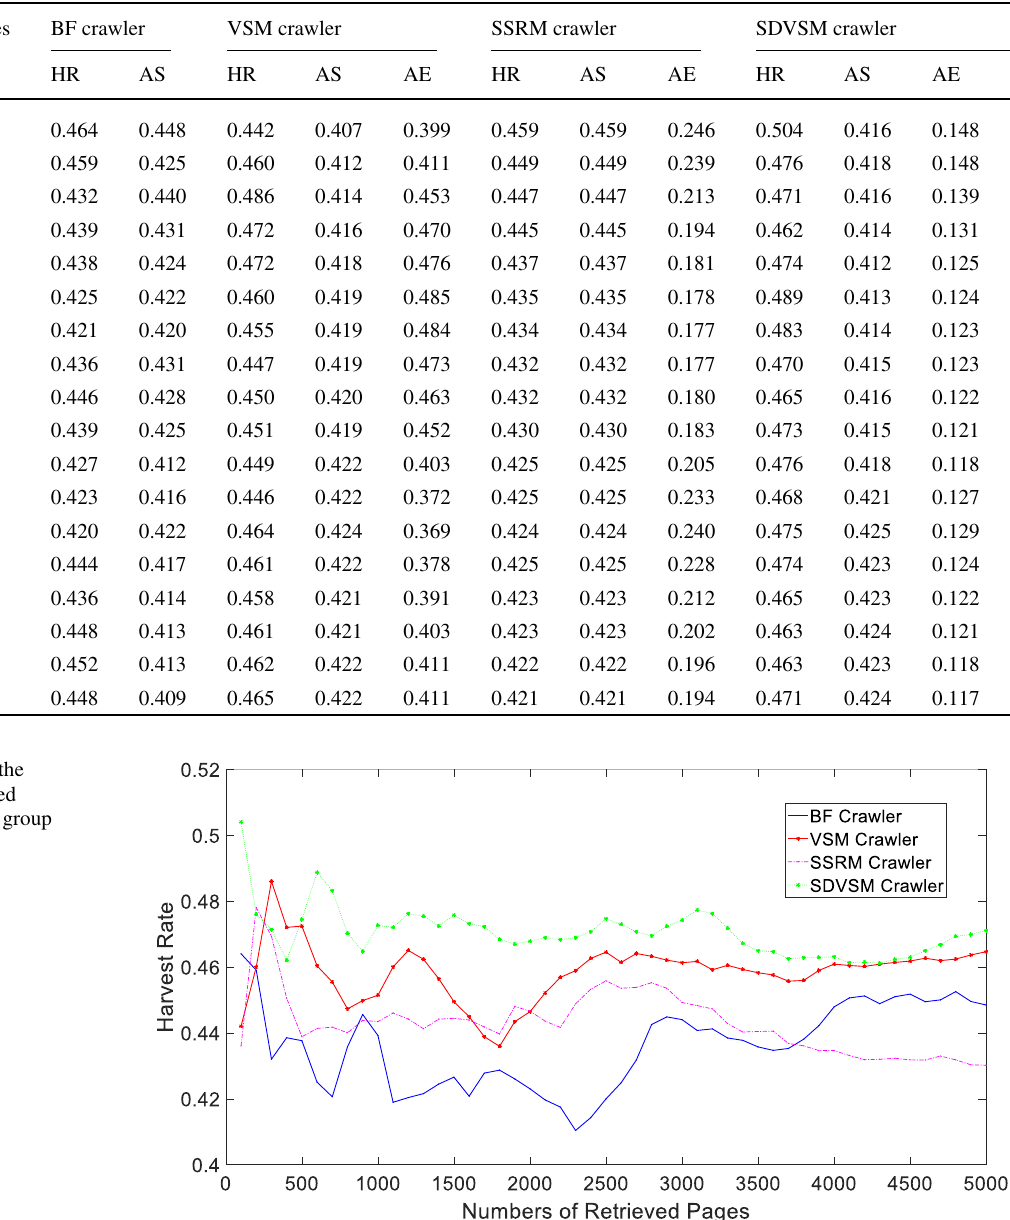
Table 4 The first group results including HR, AS and AE for four focused crawlers